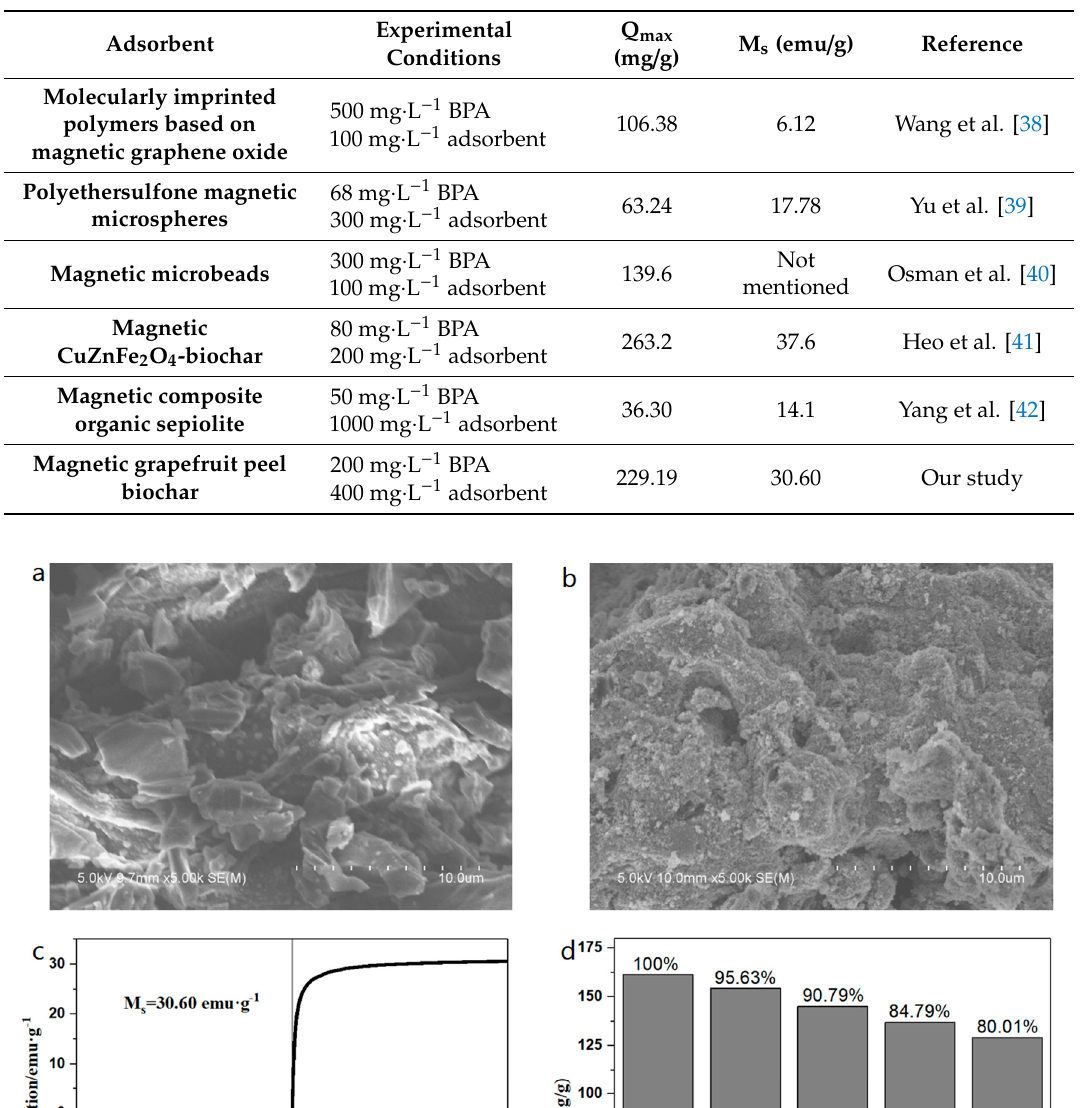
Table 3. Comparison of BPA removal by reported adsorbents in the literature and this study.